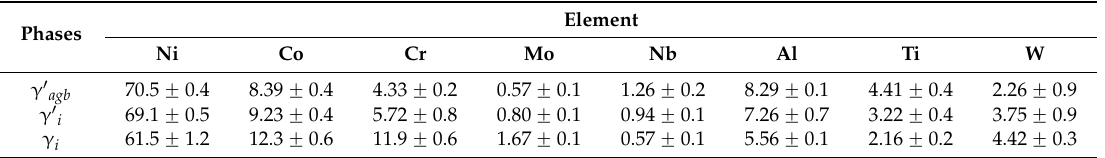
Table 2. Chemical compositions of γ and γ 1 phases in K465 superalloy substrate by EPMA (mass fraction,